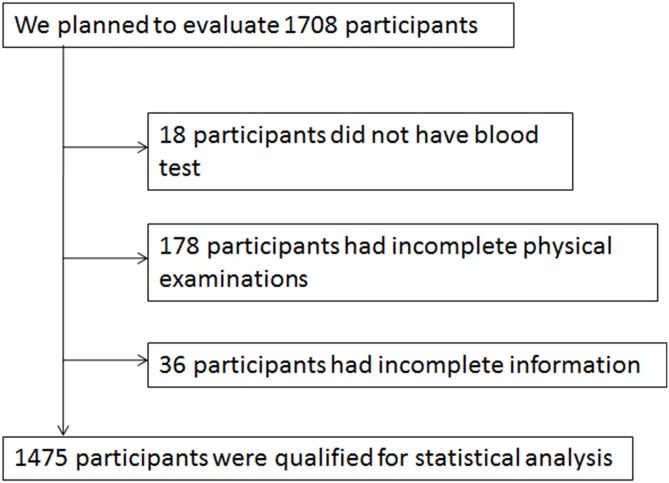
Flow diagram of participant enrollment.